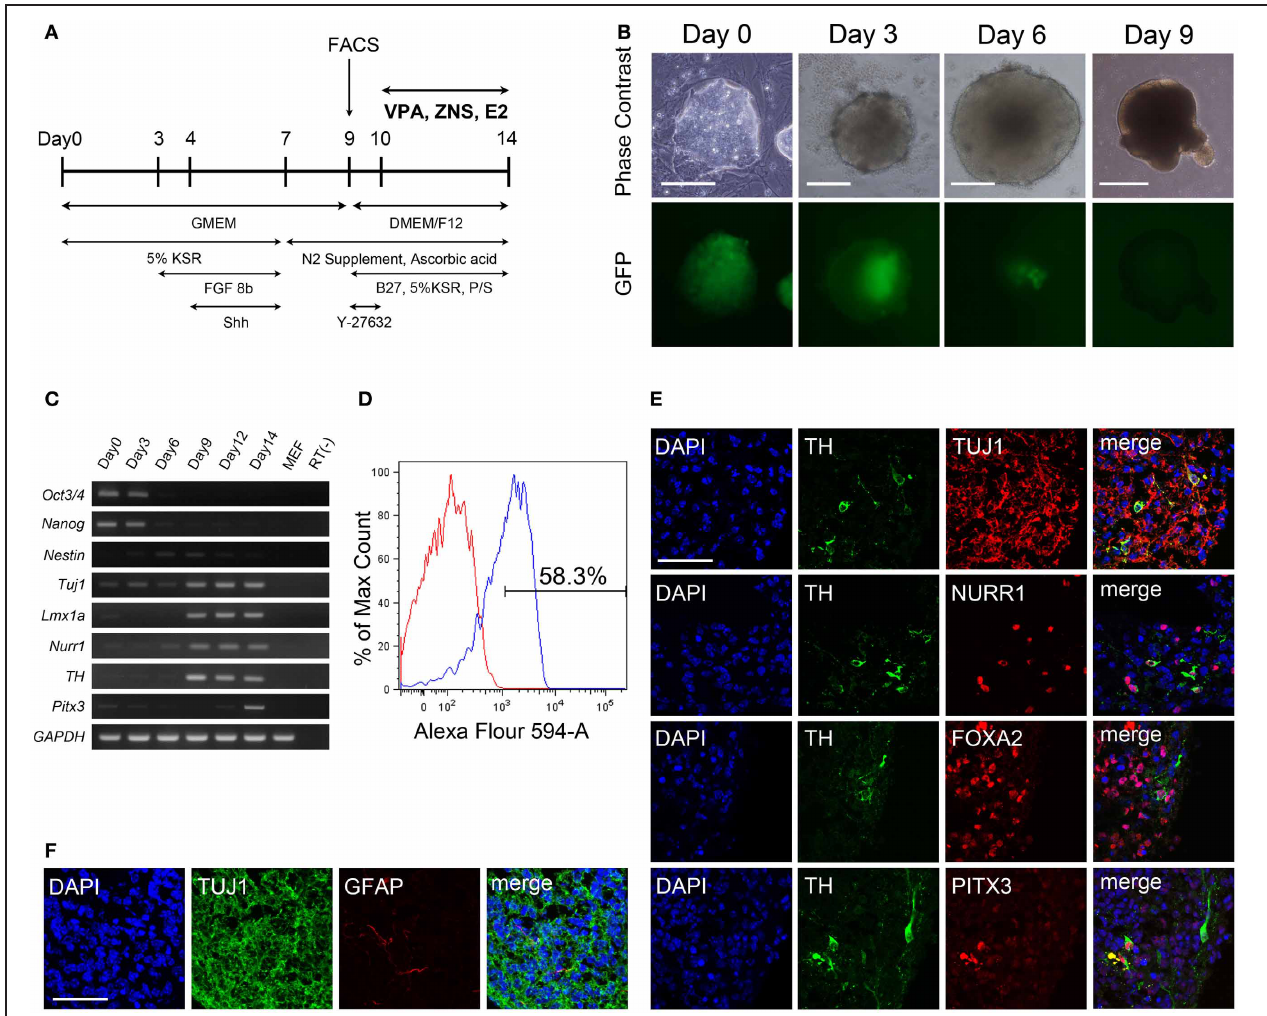
associated with pluripotency (Oct3/4, nanog), immature NPCs (nestin), post-mitotic neurons (Tuj1), and DA neurons (Lmx1a, Nurr1, TH, Pitx3 ). GAPDH was used as a control. (D) A flow cytometric profile of the population at day 9 labeled by the neural cell adhesion molecule PSA-NCAM. (E,F) Immunocytochemistry of a sliced aggregate fixed on day 14 indicating the presence of DA neurons (E) and astrocytes (F) in the culture. The scale bar applies to all pictures and represents 50 μ